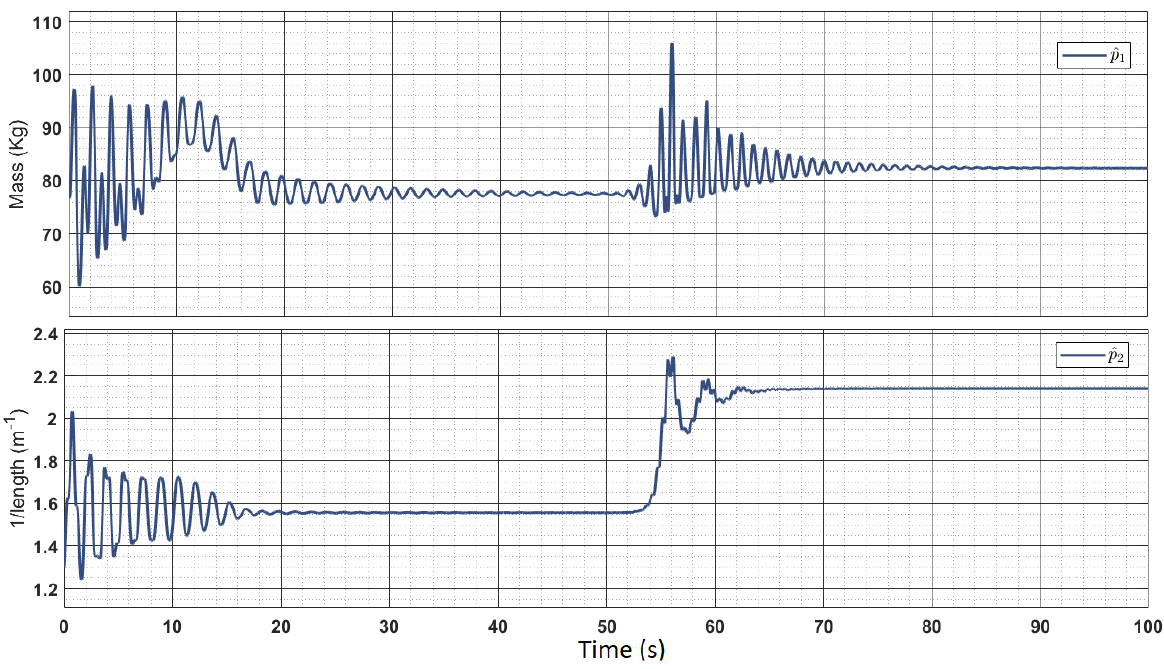
Figure 21. Parameter